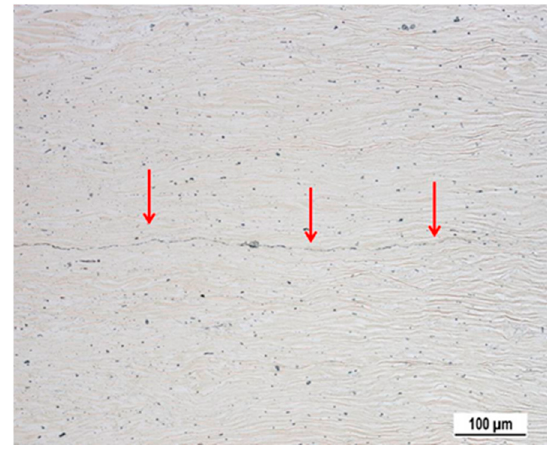
Figure 1. New interface formed in the sample after the first rolling pass. Micrograph performed in SEM Tescan.